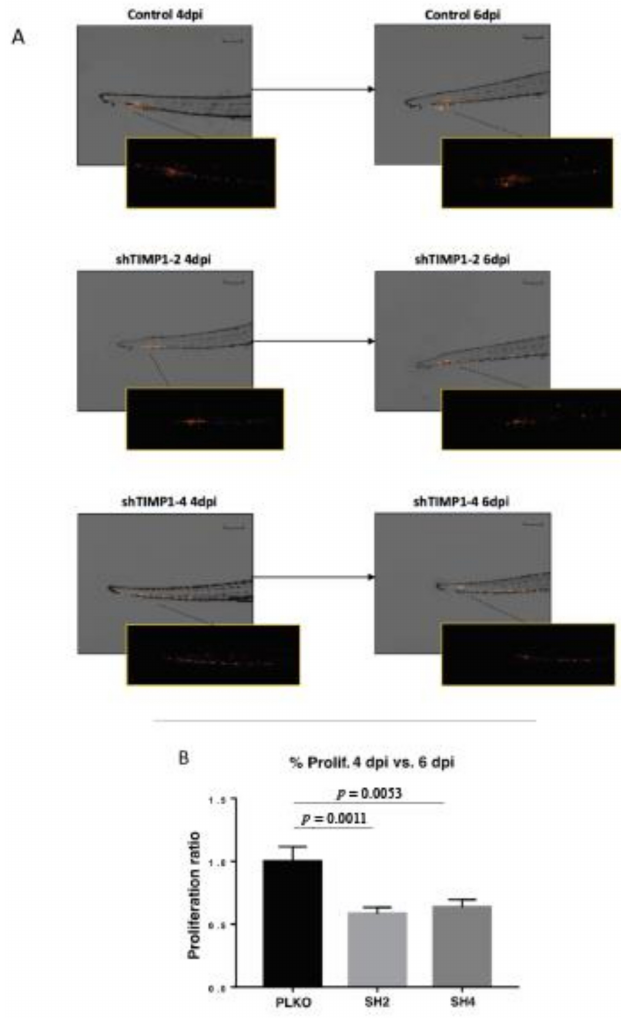
Figure 4. E ff ect of TIMP1 knock-down in MDA-MB-231 proliferation in zebrafish embryos. ( A ) Representative images of the injected embryos with the di ff erent conditions of the cell line at 4 dpi and 6 dpi compared to 1 dpi. The main images are a superposition of a fluorescence image and a bright field image of the same embryo. Fluorescence images are a magnification of the areas marked in the main image. Scale = 250 µ m. ( B ) Normalized tumor growth at 4 dpi (left panel) and 6 dpi (right panel). (n replica = 15 embryos / condition, n total = 45 embryos / condition; two-tailed T test; * p < 0.05; dpi: days